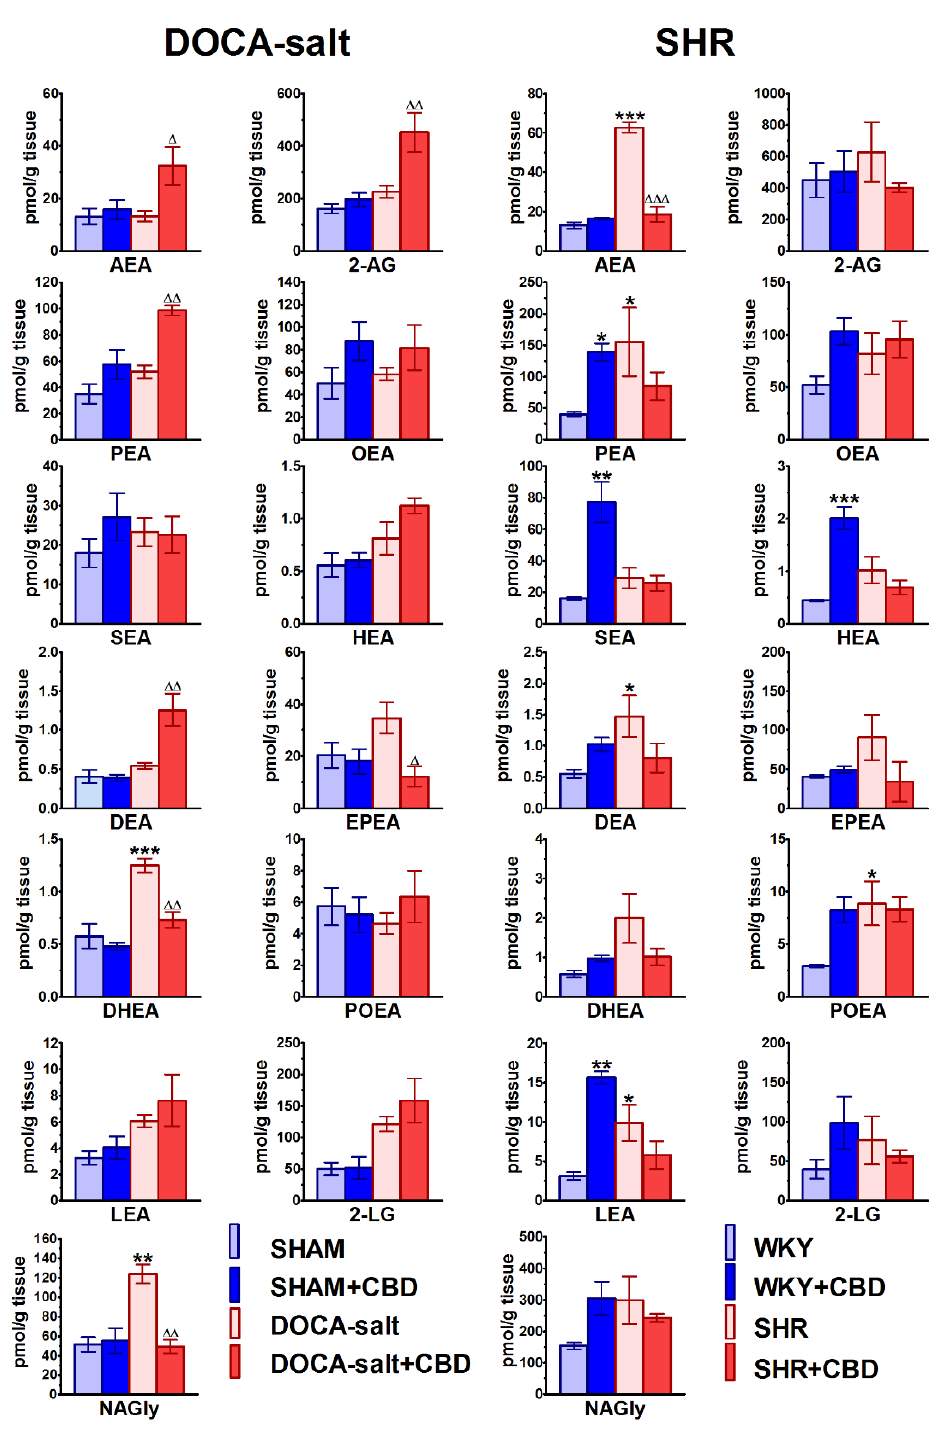
Figure 9. Influences of cannabidiol (CBD) and its vehicle on endocannabinoid levels in thoracic aorta isolated from deoxycorticosterone-induced (DOCA-salt) and spontaneously (SHR) hypertensive rats and their normotensive controls, sham-operated (SHAM) and Wistar–Kyoto (WKY) rats, respectively. CBD (10 mg/kg) or its vehicle was injected i.p. every 24 h for 14 days. Mean ± SEM of n = 6 tissues for each bar. * , ∆ p < 0.05, ** , ∆∆ p < 0.01 and ***, ∆∆∆ p < 0.001 compared to the respective control groups (* SHAM/WKY or ∆ DOCA-salt/SHR), as determined by one-way ANOVA followed by Bonferroni’s multiple-comparison tests. AEA—anandamide; 2-AG—2-arachidonoylglycerol; PEA—palmitoyl ethanolamide; OEA—oleoyl EPEA—eicosapentaenoyl ethanolamide; DHEA—docosahexaenoyl ethanolamide; POEA—palmitoleoyl ethanolamide; LEA—linolenoyl ethanolamide; 2-LG—linoleoylglycerol; NAGly—N-arachidonoyl glycine.